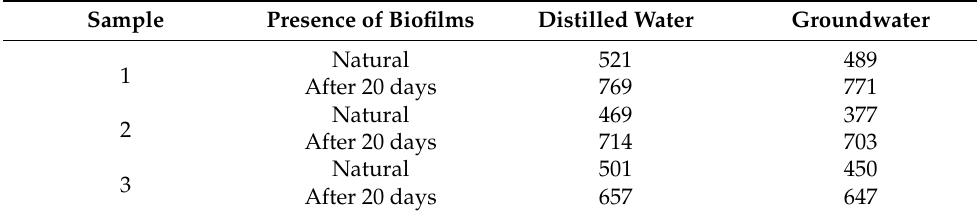
Table 7. K d values (cm 3 /g) of uranium sorption on soils before and after biofilm development from glucose–acetate activation.